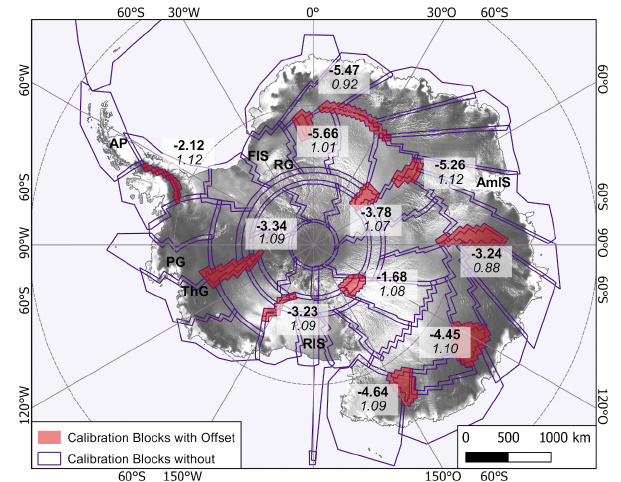
Figure 4. DEM Calibration blocks for Antarctica. The 11 red blocks were calibrated first towards ICESat, and then the mean SAR pen- etration bias was subtracted. Bold numbers: mean penetration bias per homogeneous penetration block. Italics: standard deviation of TanDEM-X to ICESat elevations. The red blocks were used as ground control areas for the remaining blocks. In black are loca- tions of interest: AP: Antarctic Peninsula; AmIS: Amery Ice Shelf; FIS: Filchner Ice Shelf; PG: Pine Island Glacier; RG: Recovery Glacier; RIS: Ross Ice Shelf; ThG: Thwaites